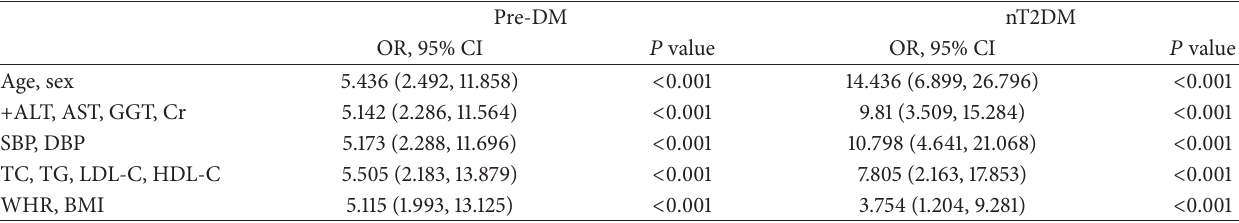
Table 4: Multiple logistic regression analyses of plasma HMGB-1 levels among various